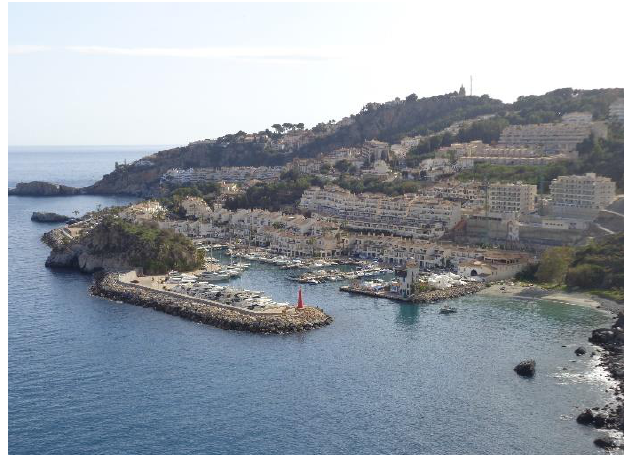
Figure 2. Location map and general view of Marina del Este. Figure 2. General view of Marina del